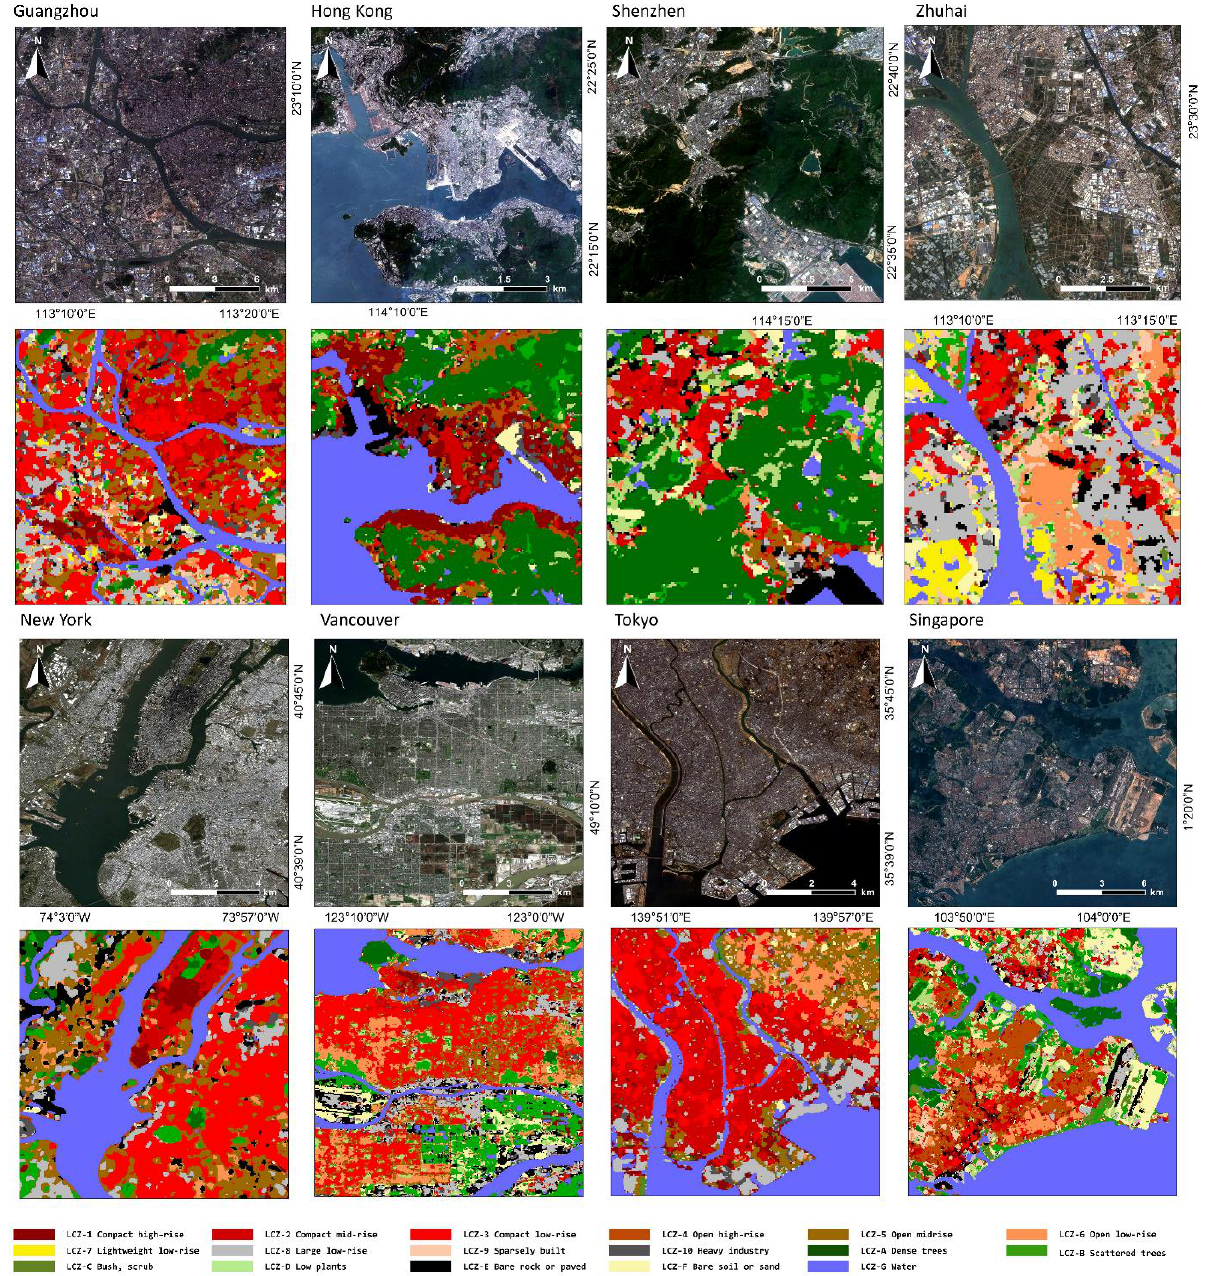
Figure 9. The LCZ maps of test cities. Here, the first and third rows display the original images, and the second and fourth image rows illustrate corresponding LCZ